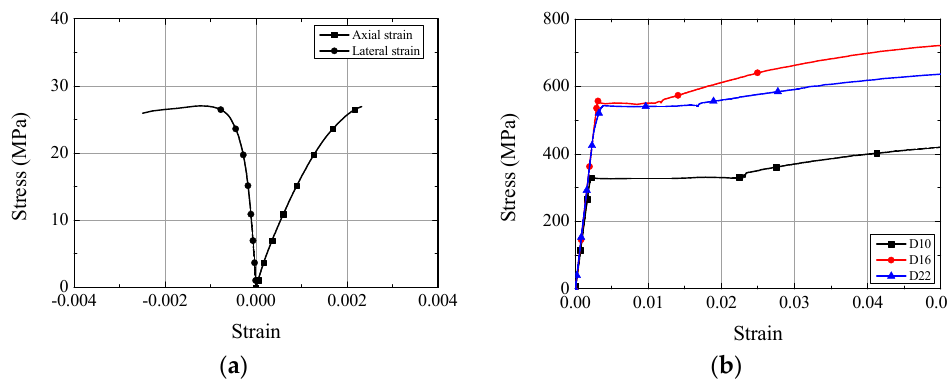
Figure 1. Stress vs. strain relationships of used materials: ( a ) concrete; ( b ) steel bars. D10 (71.3 mm 2 ), D16 (198.6 mm 2 ), and D22 (387.1 mm 2 ) reinforcing bars were used in